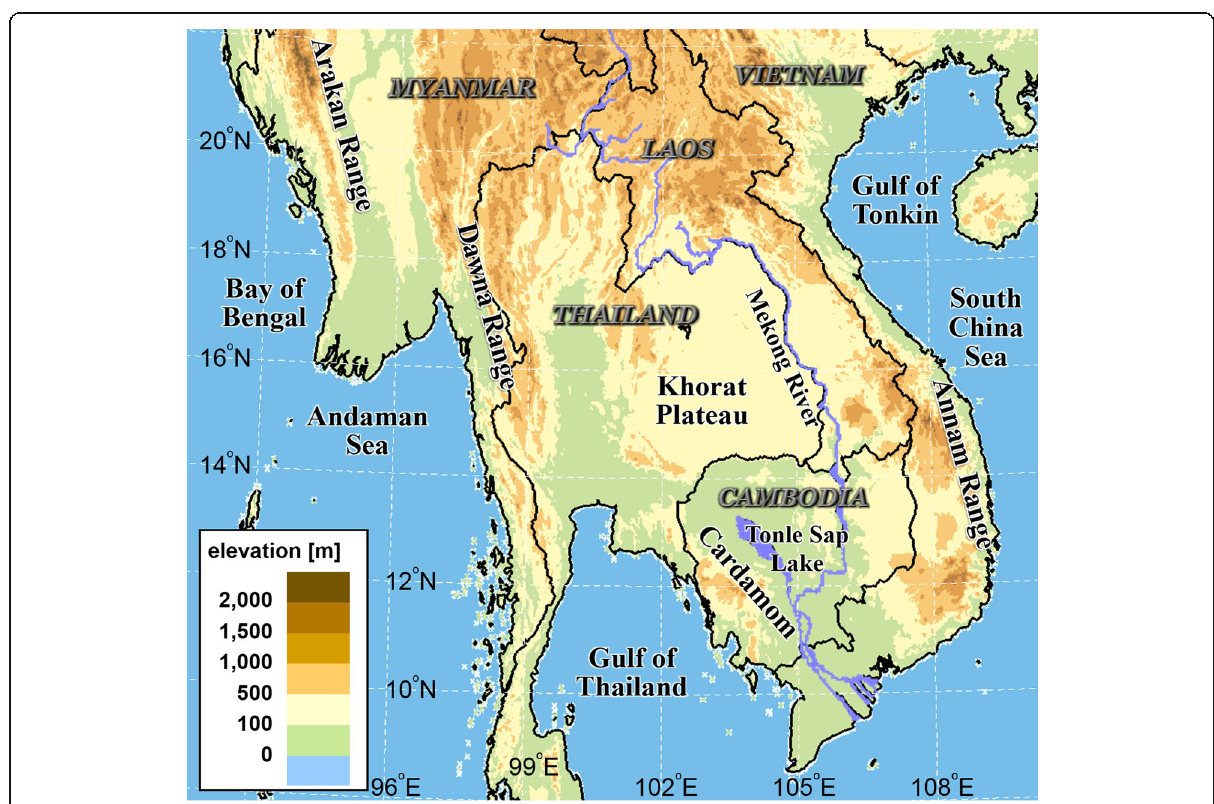
Fig. 1 Topography of the Indochina Peninsula and the location of Cambodia. The topographical map is drawn based on the Global 30 Arc-Second Elevation (GTOPO30) data provided by the US Geological